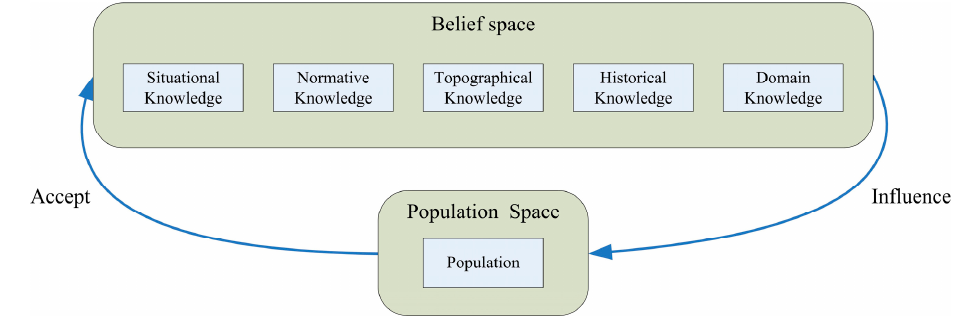
Figure 1. The framework of a cultural algorithm.